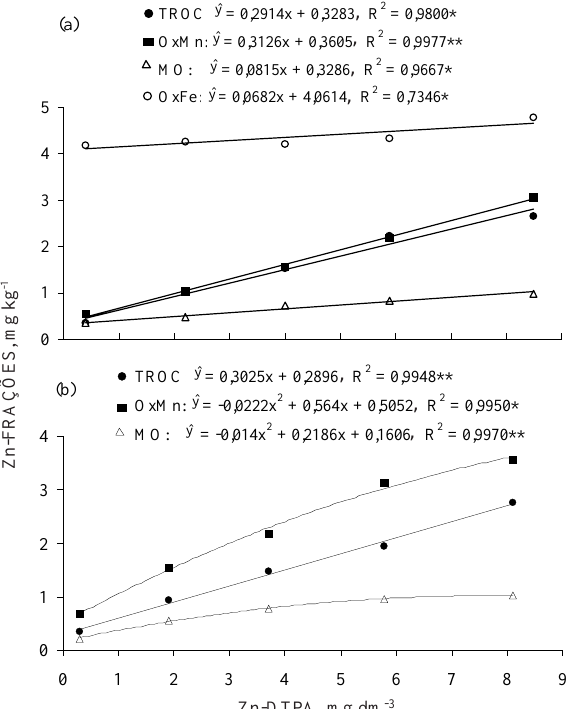
Figura 2. Relação entre as frações de Zn e o extraído por DTPA em amostras de solo sem calagem (a) e com calagem (b), coletadas antes do